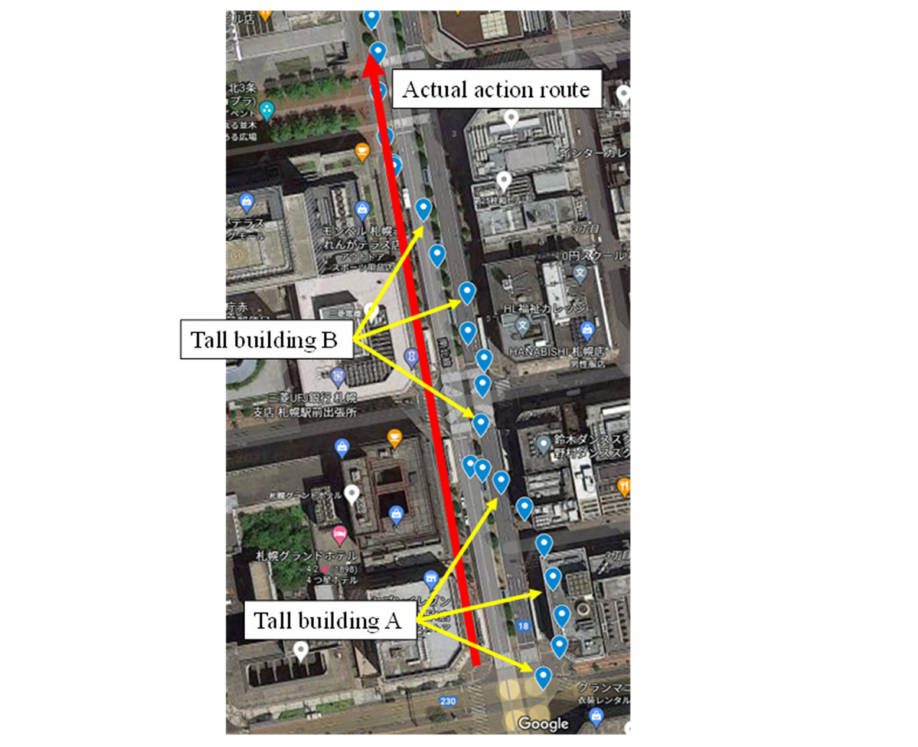
Figure 6. GPS location and its error in urban area (Sapporo, Hokkaido, Japan).